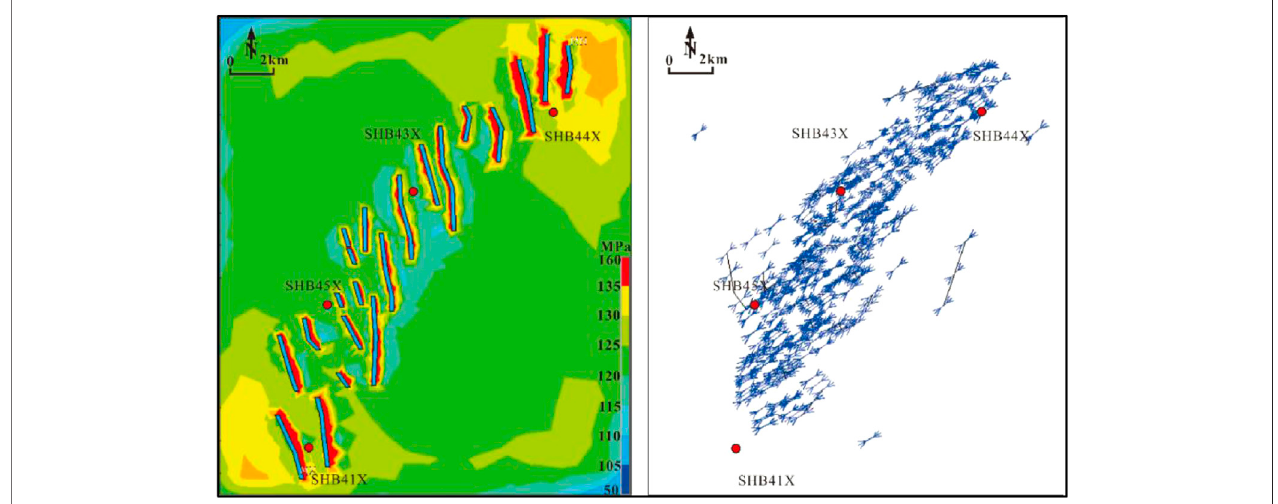
FIGURE 13 | Planar distribution of the maximum principal stress and direction at the T 63 interface of the Shunbei No. A Fault Zone.